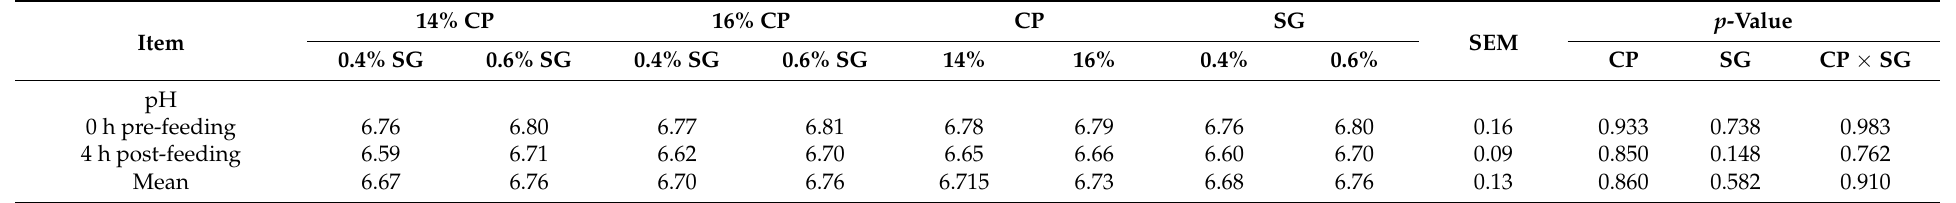
Table 4. Effects of crude protein (CP) levels (14% vs. 16%) in concentrate with S. graniflora pod meal (SG, 0.4% vs. 0.6% dry matter intake) on ruminal pH, ammonia nitrogen, ruminal protozoal population, and blood urea nitrogen concentration in Thai native beef